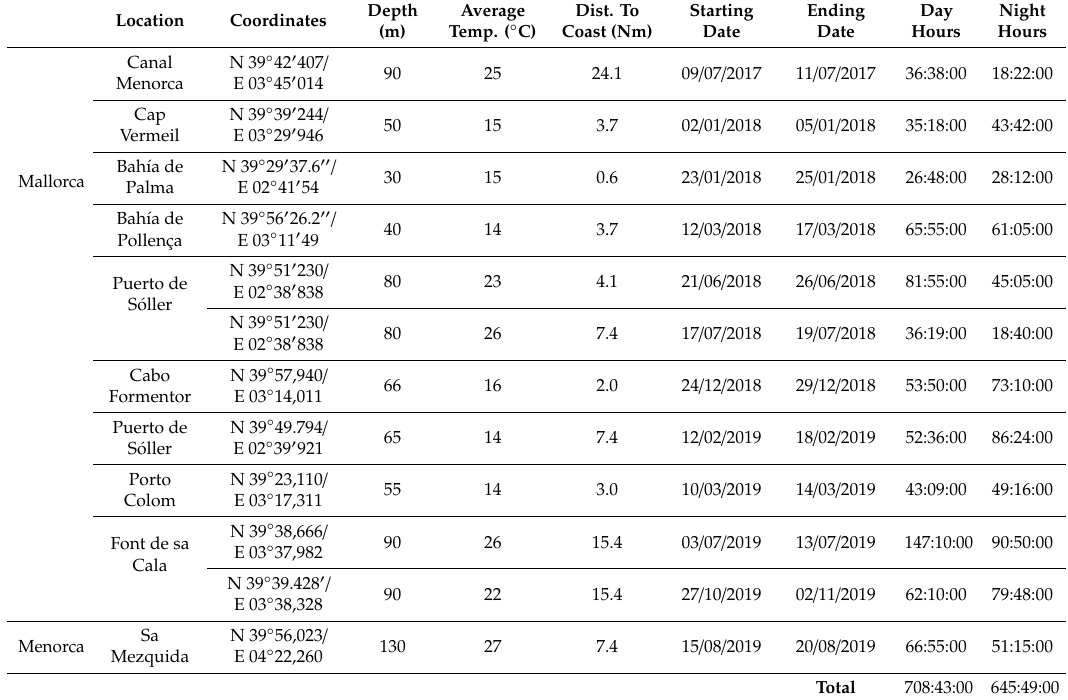
Table 1. Details of baited remote underwater video systems (BRUV) sampling e ff ort around Mallorca and Menorca islands. Location Coordinates